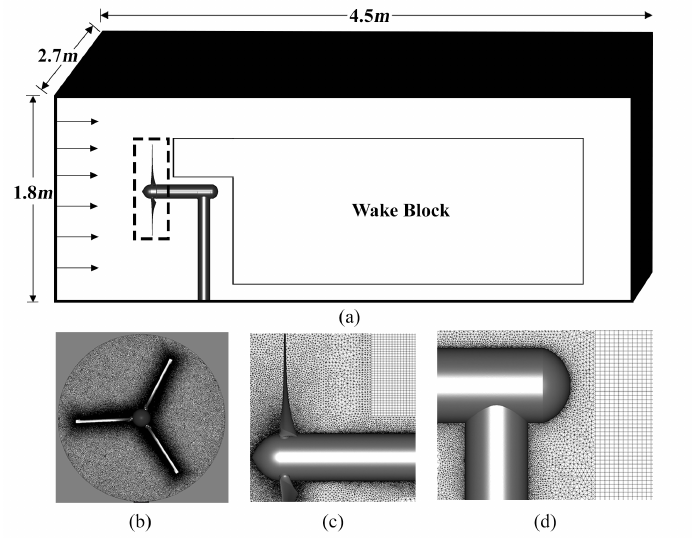
Figure 3. HAWT-S826: The representation of ( a ) computational domain and ( b – d ) hybrid computa- tional mesh generated for the full turbine in Case-V. The section view of the turbine blades is also illustrated with the front view and the rotor’s snippet. The mesh constitutes structured elements close to the turbine structure which transitions to tetrahedral elements in an outward direction. A wake block with hexahedral cells is placed in the wake region to allow accurate wake estimates. The overall mesh consists of nearly 4.0 × 10 6